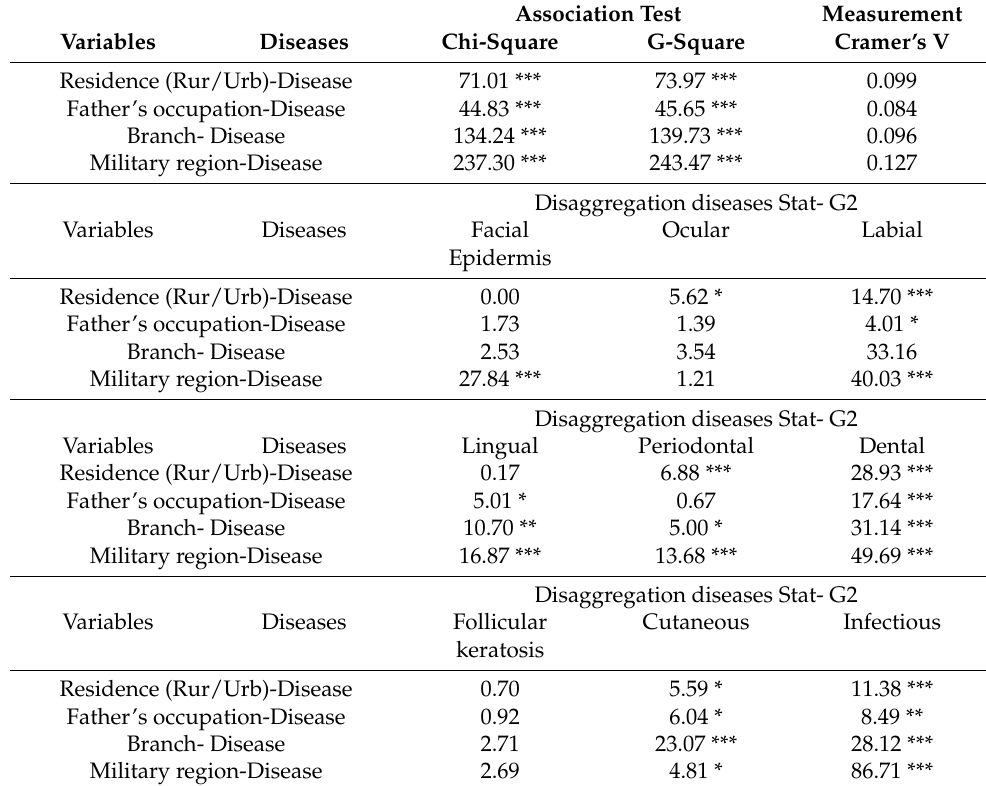
Table 8. Detailed medical check-up: Statistical association analysis between variables.